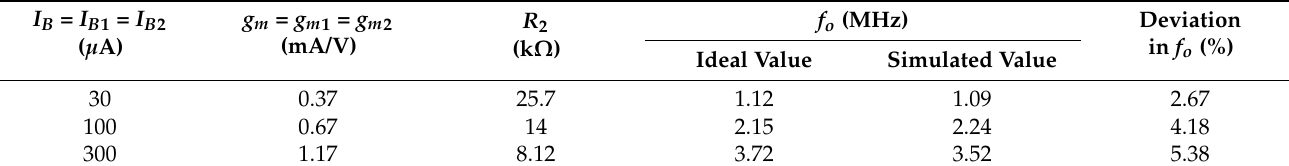
Table 4. Details of component settings used to obtain a specified f o in Figure 11.